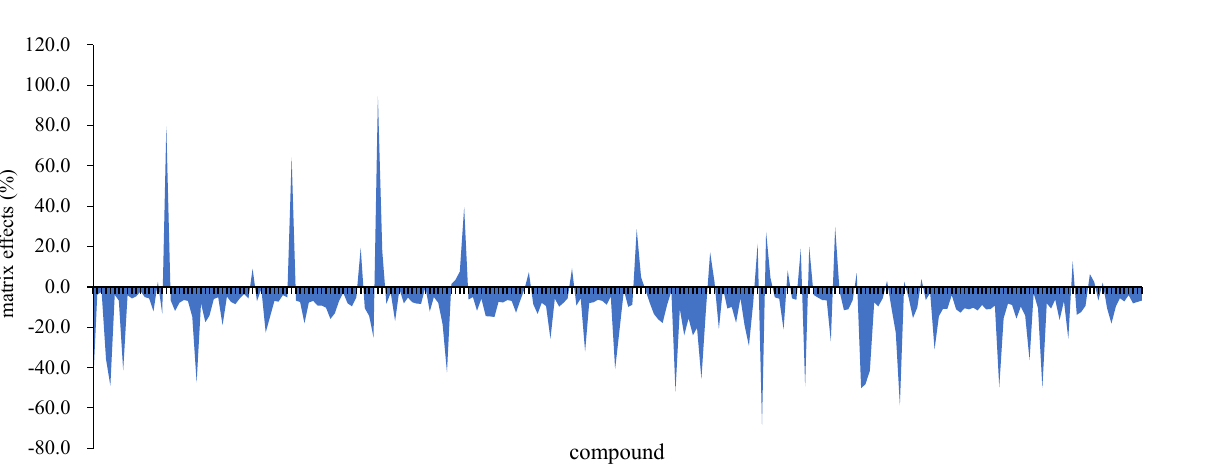
Table 1. The results of method validation for determination of 244 chemical contaminants in egg.